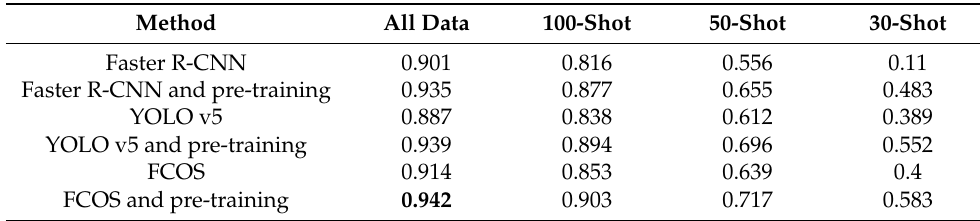
Table 5. Ship detection results (AP) of different target detection frameworks.